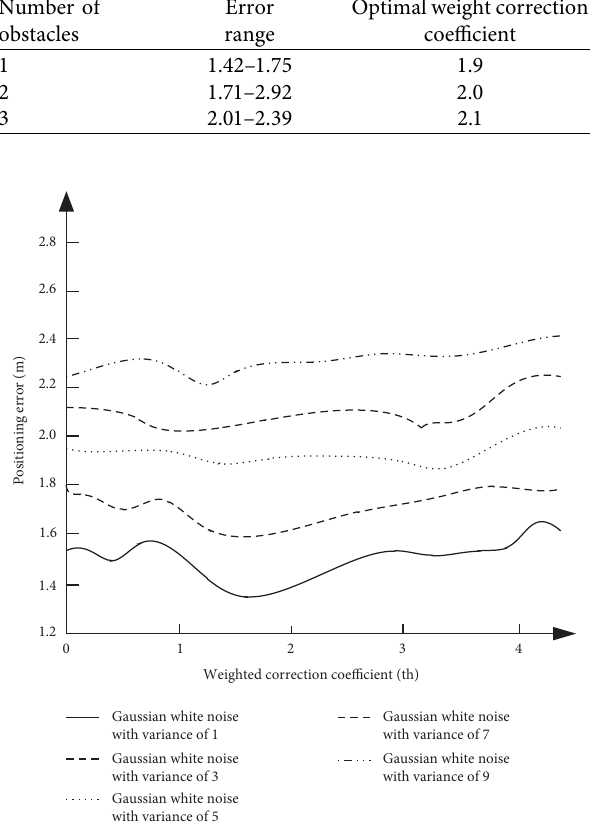
Figure 10: Interference intensity influence diagram.